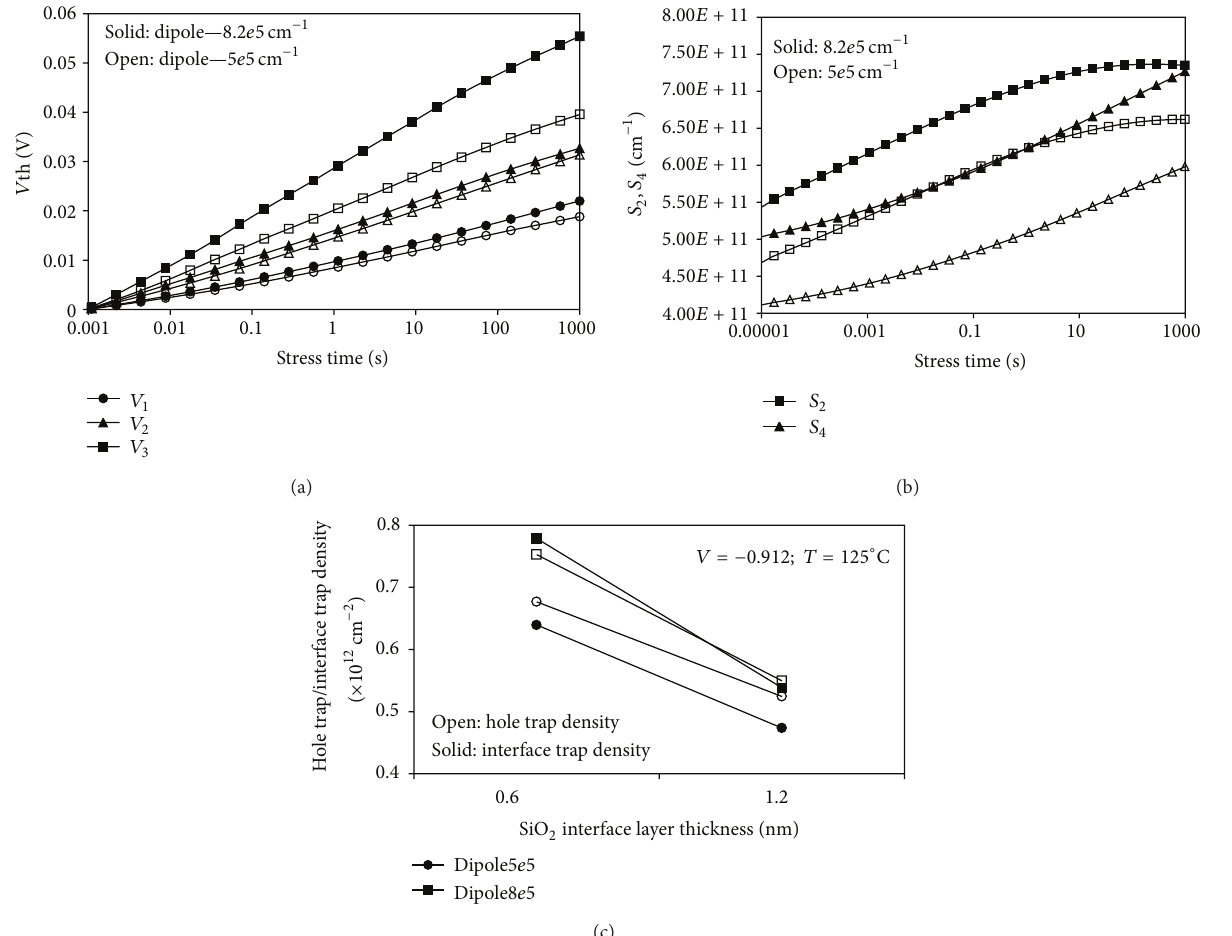
Figure 12: (a) Threshold voltage shift (𝑉 1 < 𝑉 2 < 𝑉 3 ) and (b) time evolution of hole and interface trap densities because of the effect of different dipole surface densities. (c) Hole and interface trap densities in relation to different SiO 2 interface layer thickness for a different dipole